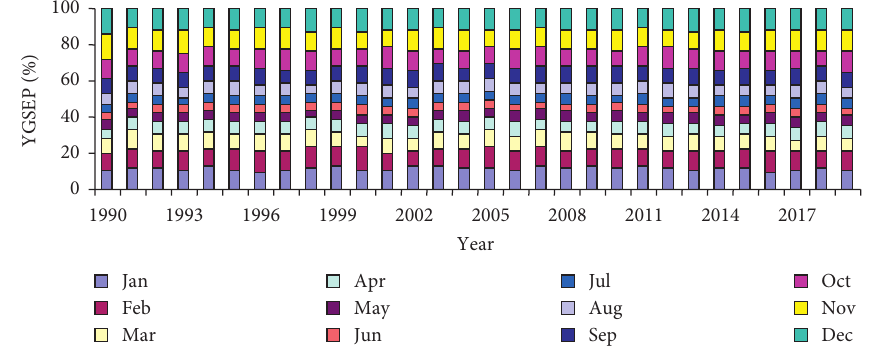
Figure 4: Yearly global solar energy percentage in Queensland,